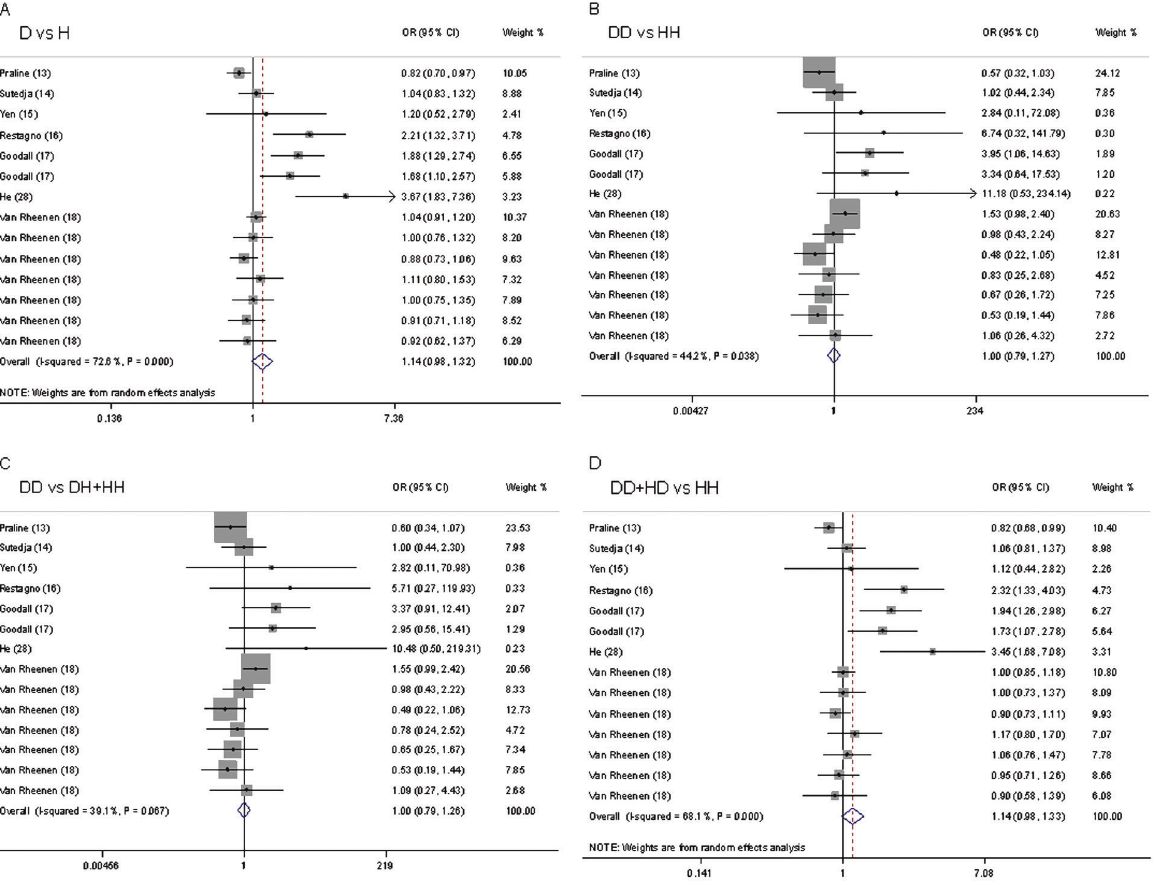
Figure 3. Forest plot of the association between ALS and the HFE H63D mutation. A , D vs H; B , DD vs HH; C , DD vs DH++HH; D , DD++HD vs